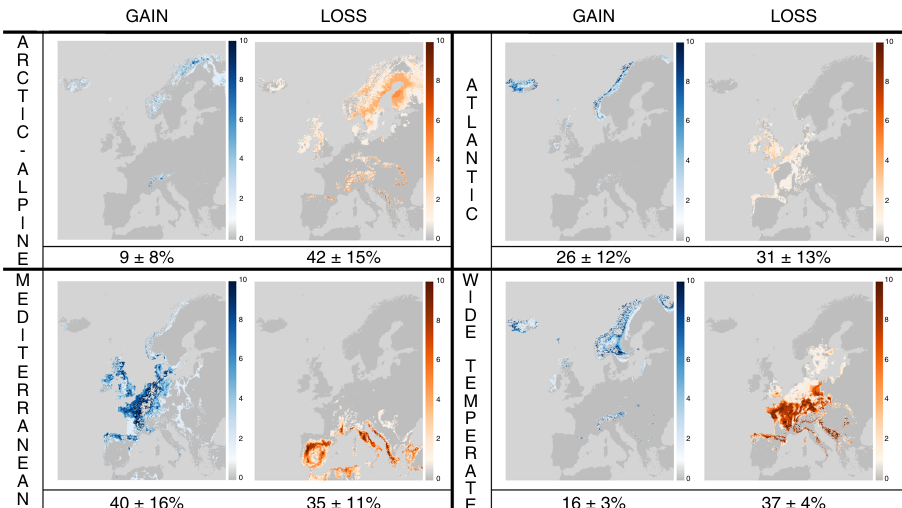
Fig. 1 Predicted impact of future climate change for the potential distribution of European bryophytes. The maps represent the distribution of 1 km 2 pixels predicted to become climatically suitable and unsuitable in 2050 for 10 representative bryophyte species of each of the four main biogeographic elements in Europe (Mediterranean, Atlantic, wide-temperate and Arctic-Alpine) using ensemble of climatic suitability models with the MPI-ESM-LR Global Circulation Model under scenario RCP8.5 (see Supplementary Fig. 1 for scenario RCP4.5 and Supplementary Figs. 2 and 3 for the two RCPs with the HadGem2-ES Global Circulation Model). Colours represent the proportion of species, computed over 10 species per biogeographical elements (individual maps are available from Figshare, DOI: 10.6084/m9. fi gshare.8289698), for which a pixel becomes suitable (blue) and unsuitable (red). Numbers indicate the average (±S.D.) percentage of the predicted increase (number of pixels that become suitable in 2050) and loss (number of pixels that become unsuitable in 2050), respectively, of suitable area in 2050 as compared to the extent number of suitable